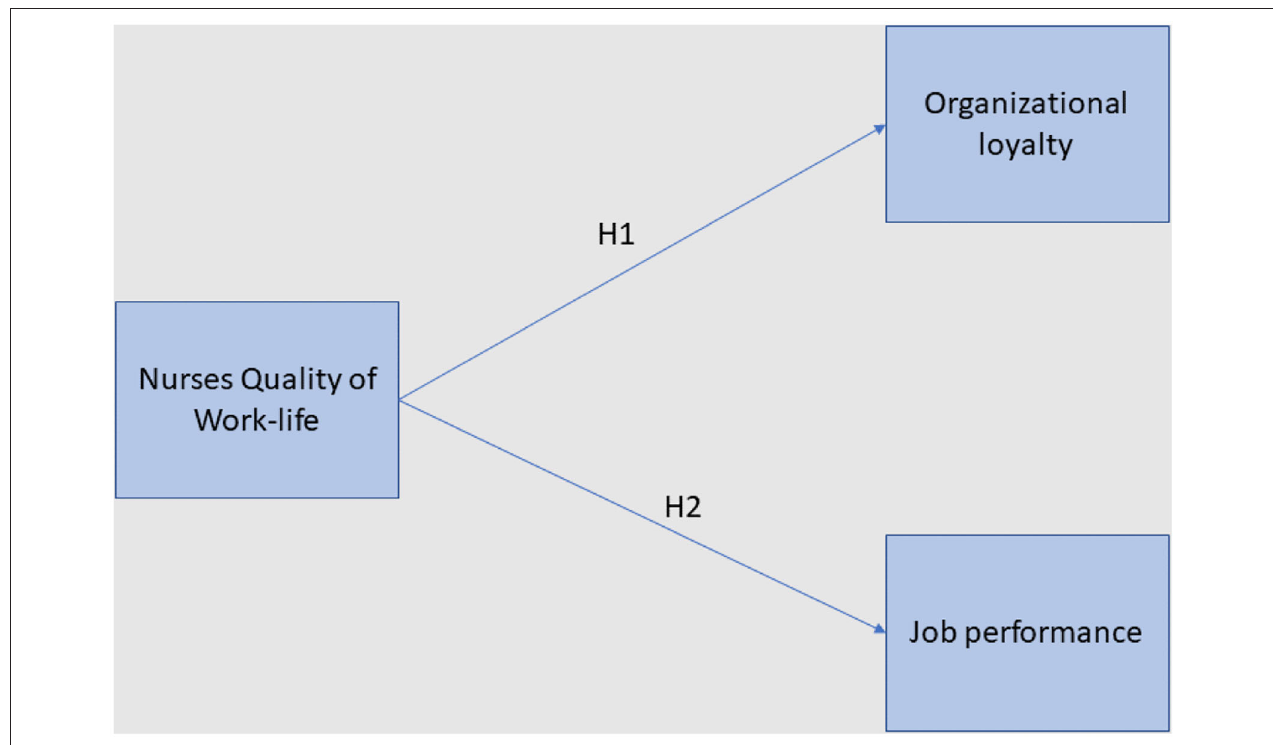
FIGURE 1 | Study model.